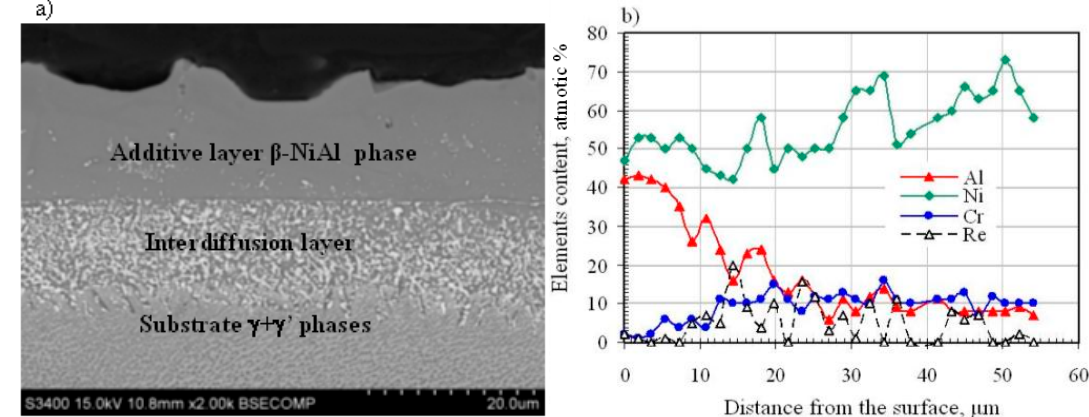
Figure 2. Microstructure ( a ) and elements’ distribution ( b ) on the cross-section of the nonmodified aluminide coating.